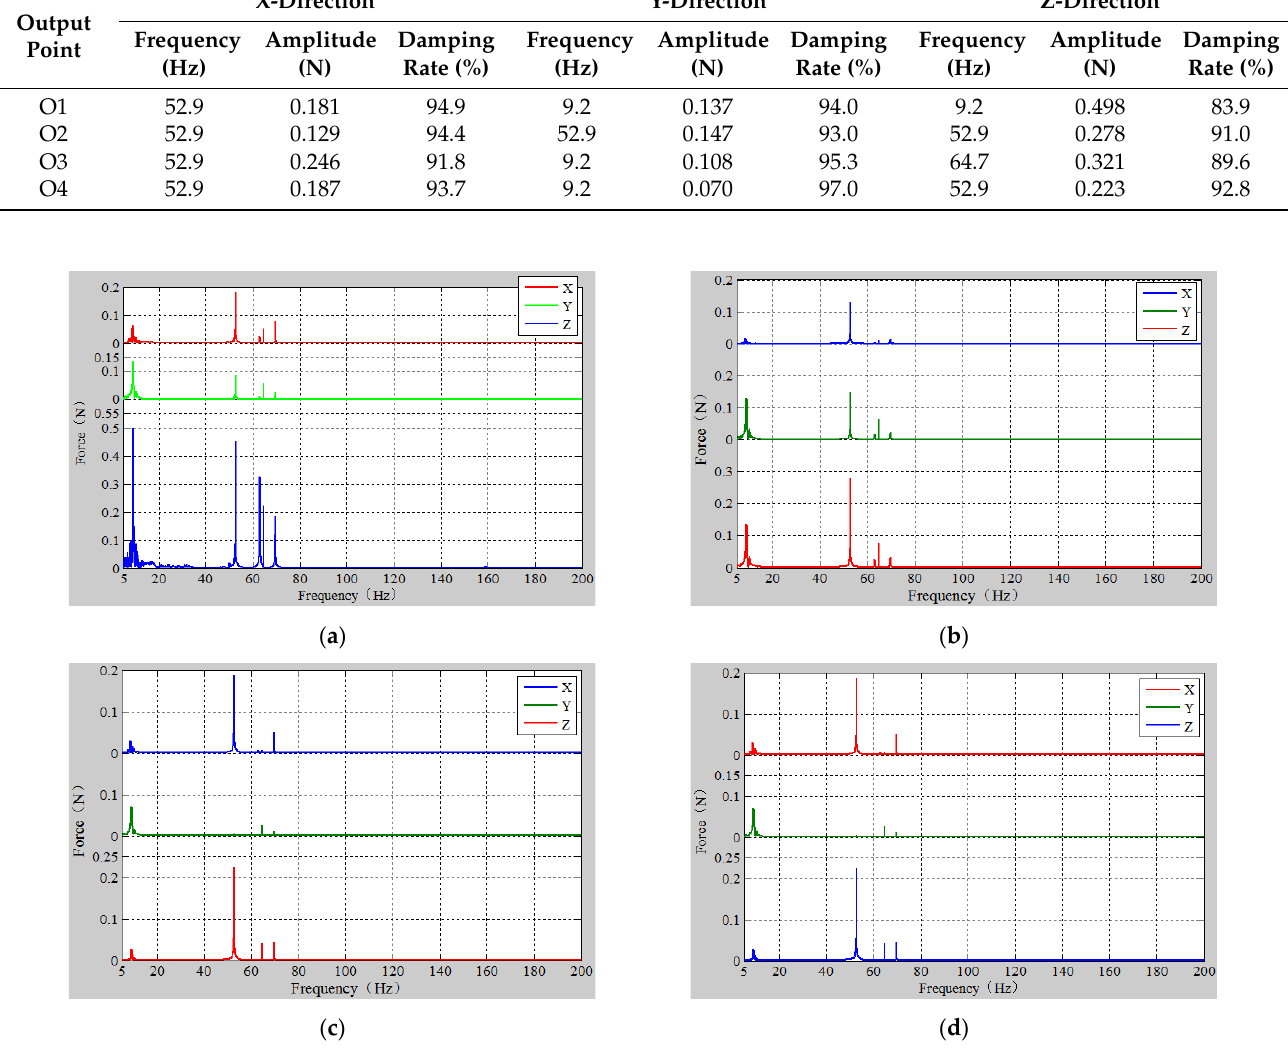
Table 1. Maximum reaction force of each output point and damping efficiency.